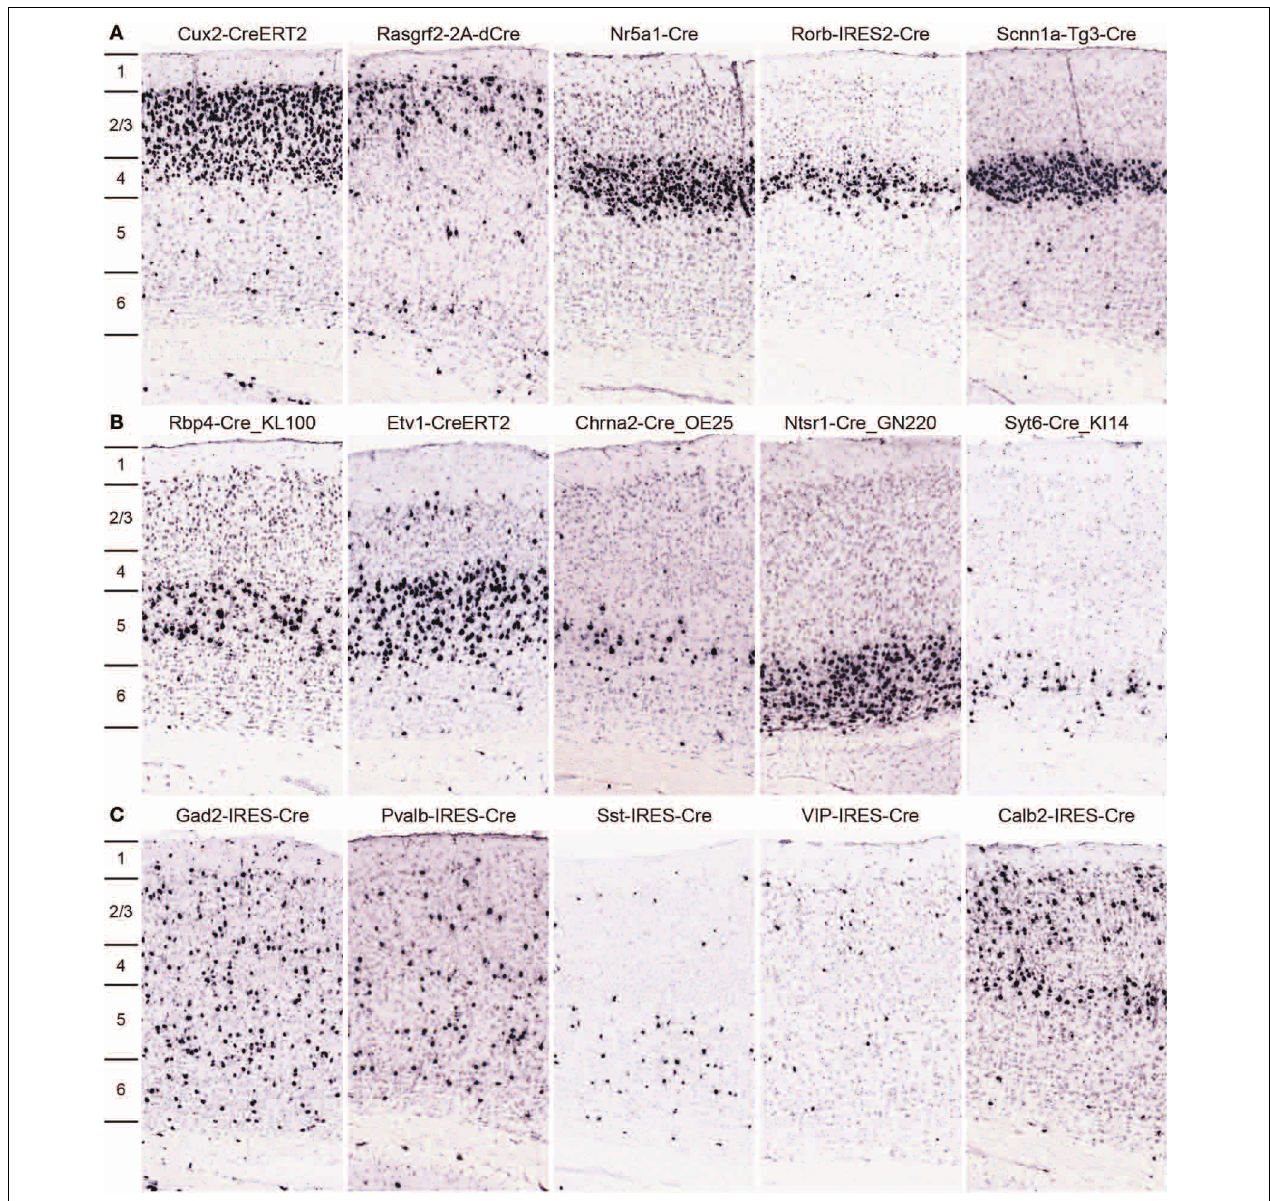
FIGURE 6 | Cre lines provide genetic access to specific cortical layers and cortical interneurons for circuit analyses. (A,B) Many Cre lines have been generated with selective expression in distinct cortical layers. Representative tdTomato ISH images are shown from a subset of Cre lines with preferential expression in neurons of layers 2/3 (Cux2-CreERT2, Rasgrf2-2A-dCre), layer 4 (Nr5a1-Cre, Rorb-IRES2-Cre, Scnn1a-Tg3-Cre), layer 5 (Rbp4-Cre_KL100, Etv1-CreERT2, Chrna2-Cre_OE25), and layer 6